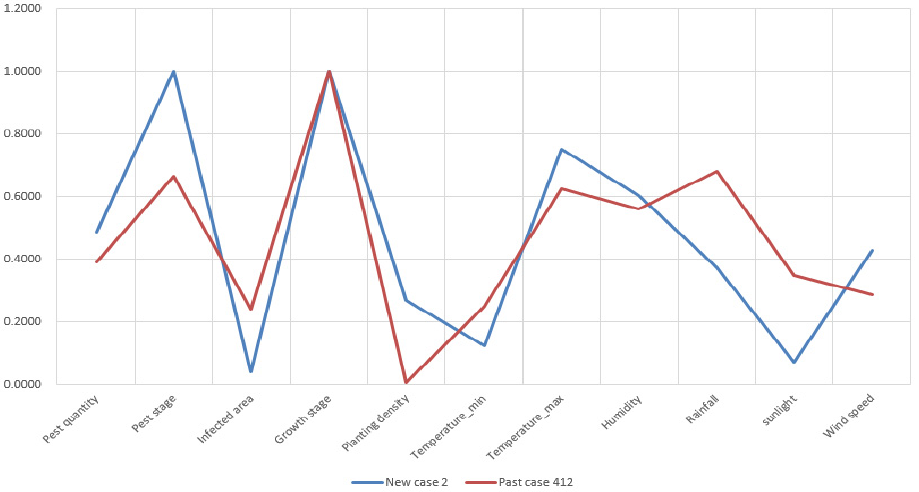
Figure A2. Attribute visualization of new case 2 and retrieved past case 412.